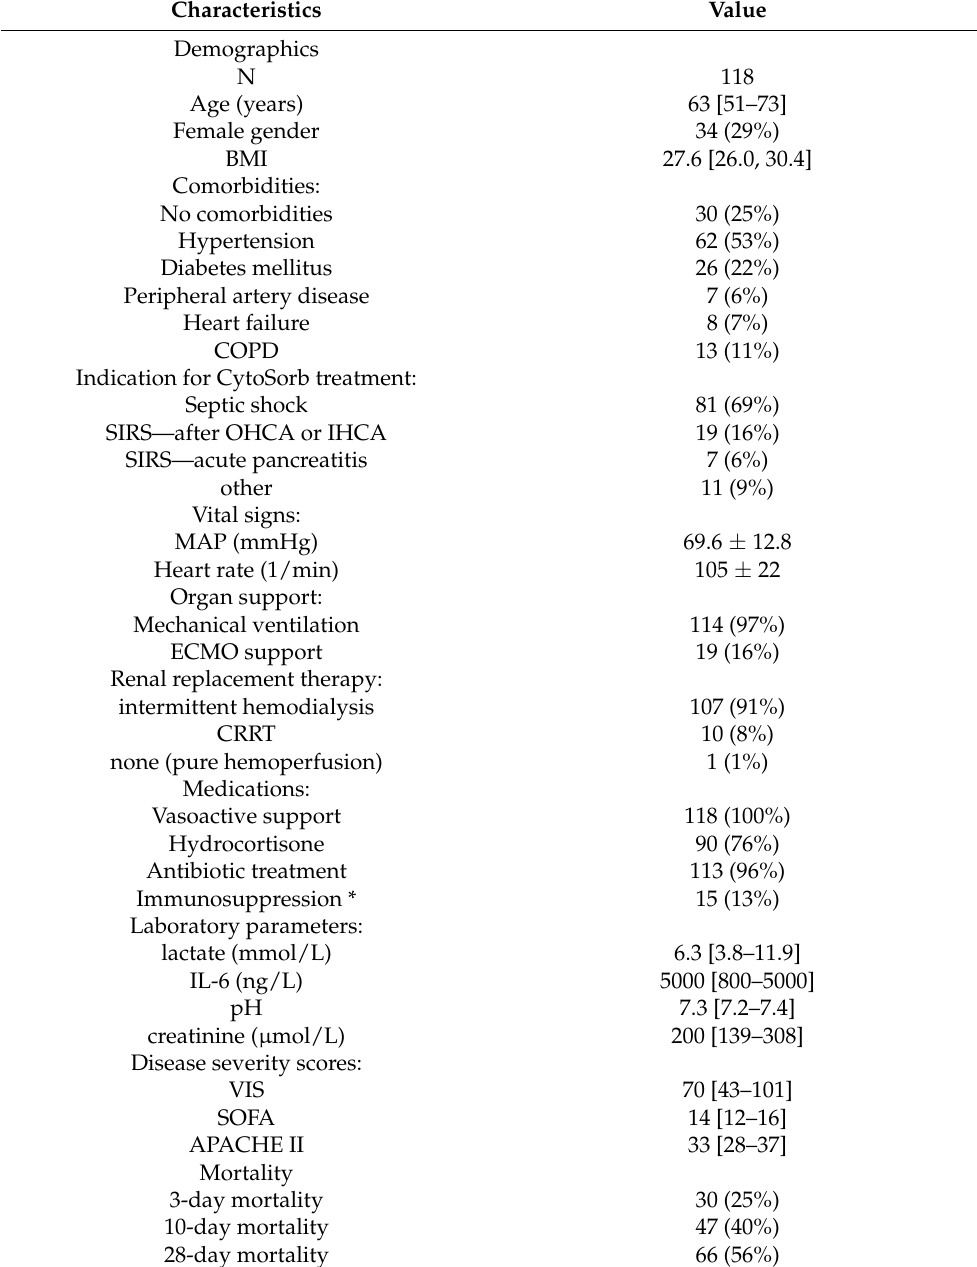
Table 1. Patients’ characteristics at initiation of treatment and outcome. Data are presented as mean ± standard deviation, median [interquartile range] and number (percent) as